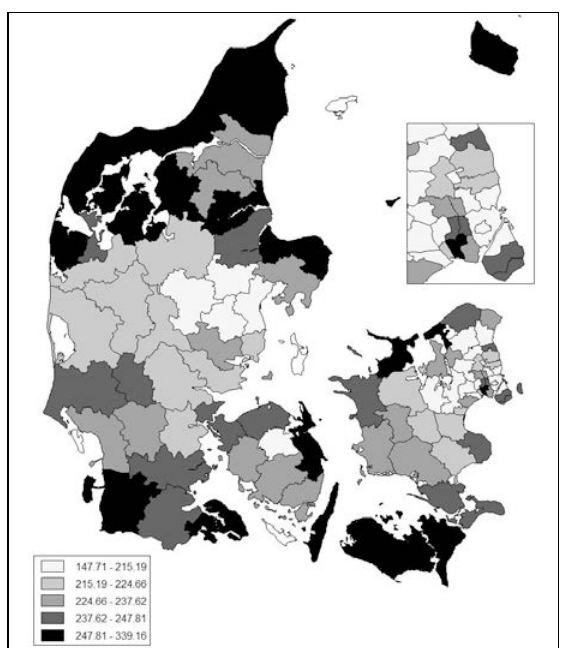
Figure 2. Number of medicated for cardiovascular diseases per 1000